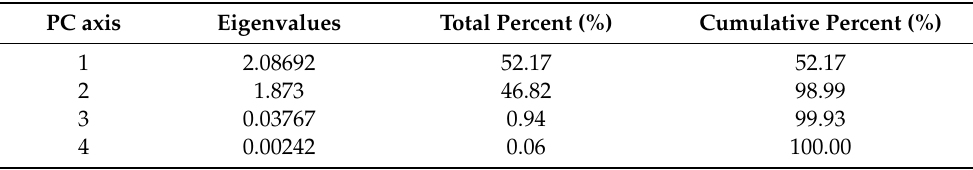
Table 4. Total and cumulative percentages and respective eigenvalues of each axis considered. PC axis